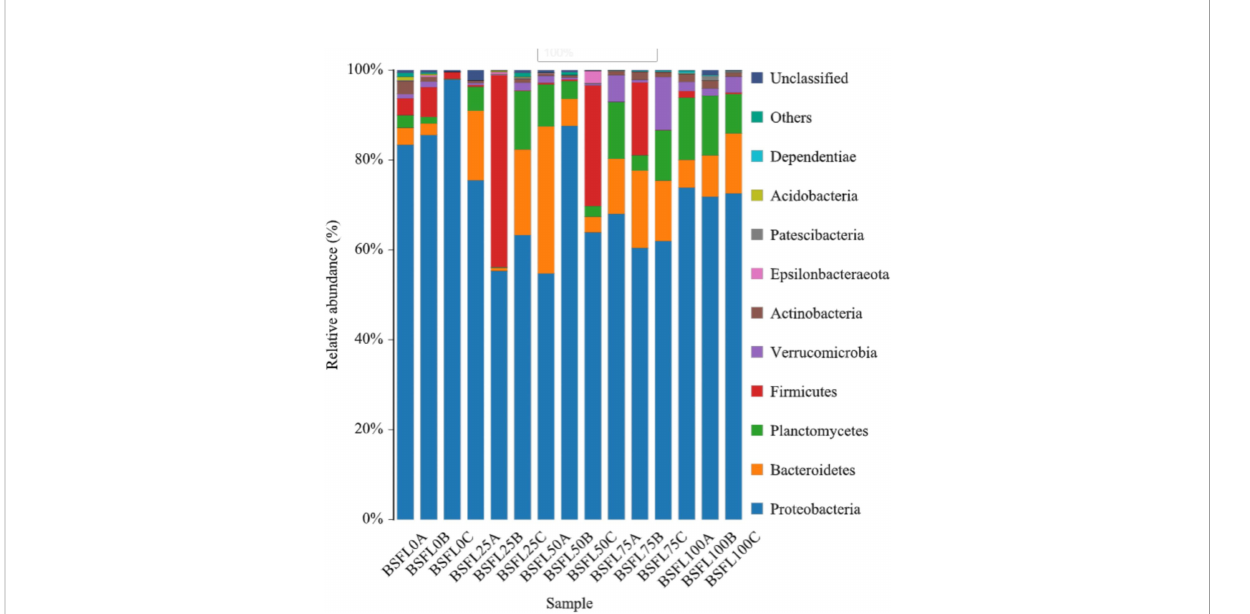
FIGURE 5 Relative abundances of bacterial phyla in the intestine of L. vannamei fed with diets having different levels of BSFL. The most dominant phyla (> 1% of the total sequences) are shown in the schematic individually, and the relative abundances of main phyla is indicated in Table